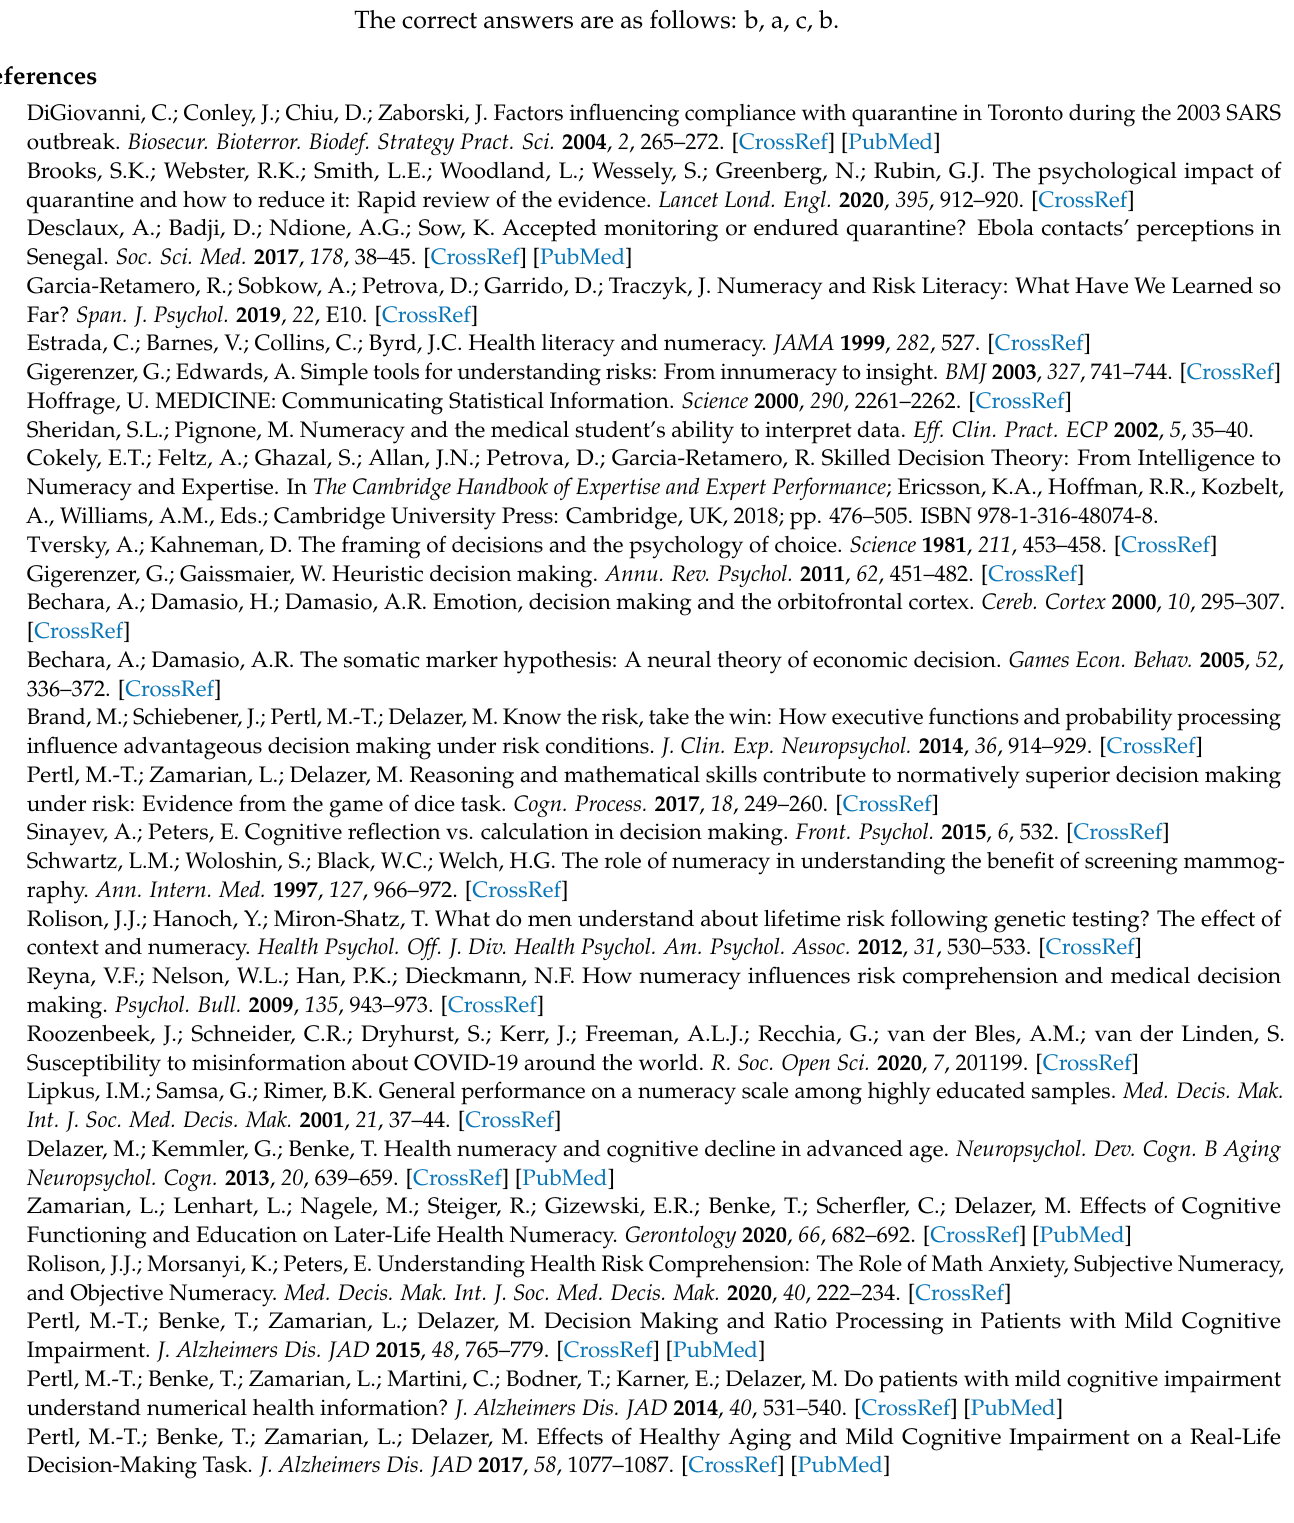
4. The number of infections increases daily by about 30%. Which row of numbers does correspond to this growth? (a) 1000—1300—1600 (b) 100—130—169 (c) 10—30—90 The correct answers are as follows: b, a, c,